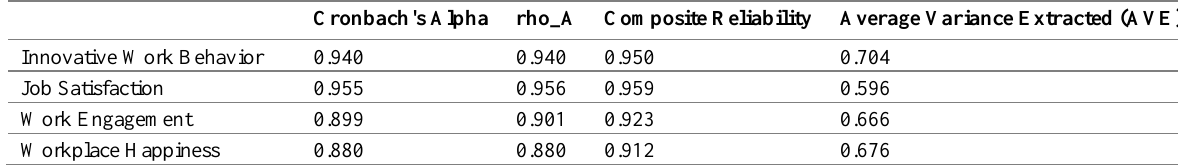
Table 4: Results of Composite Reliability